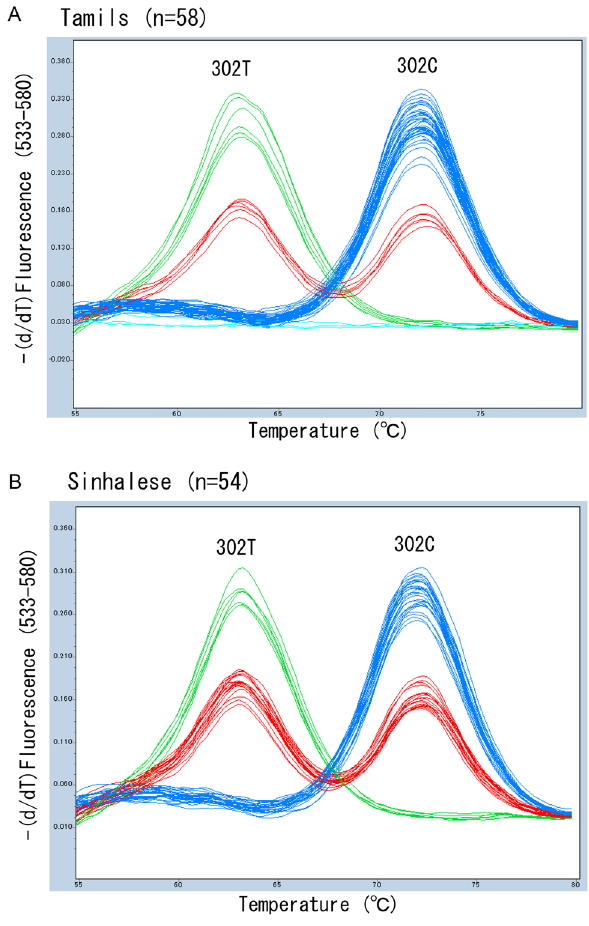
Figure 3. Melting peak profiles of Eprobe-PCR for detection of 302C > T of FUT2 . Melting peak profiles obtained for 58 Tamils ( A ) and 54 Sinhalese ( B ). The individuals with genotypes of C/C (blue), C/T (red), and T/T (green) at rs200157007 were completely separated by melt curve genotyping. In addition, no amplification signal (and therefore no melting peak) was obtained in three Tamils who were homozygous for se del (light